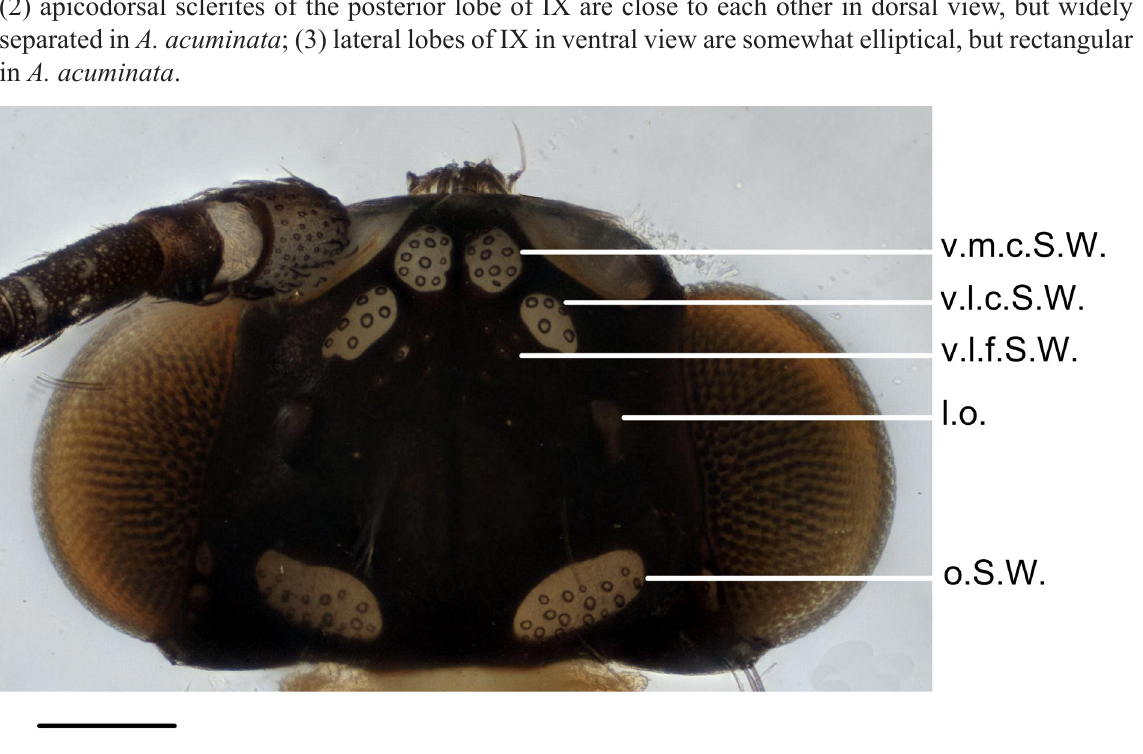
Fig. 2. Apatidelia morsei Xu & Sun sp. nov., in alcohol. Head (dorsal view). Scale bar = 0.5